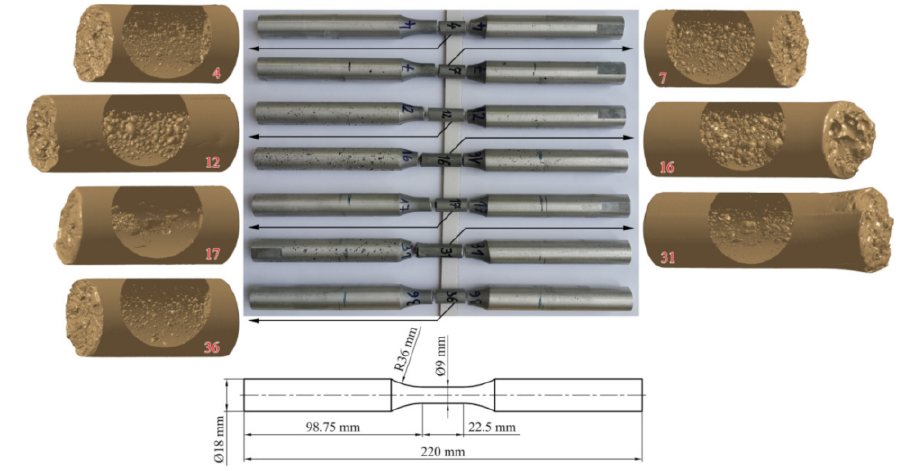
Figure 6. Specimen geometry ( bottom ), LCF-tested specimens ( top ), µ -CT-scanned samples for analysis of results ( left / right